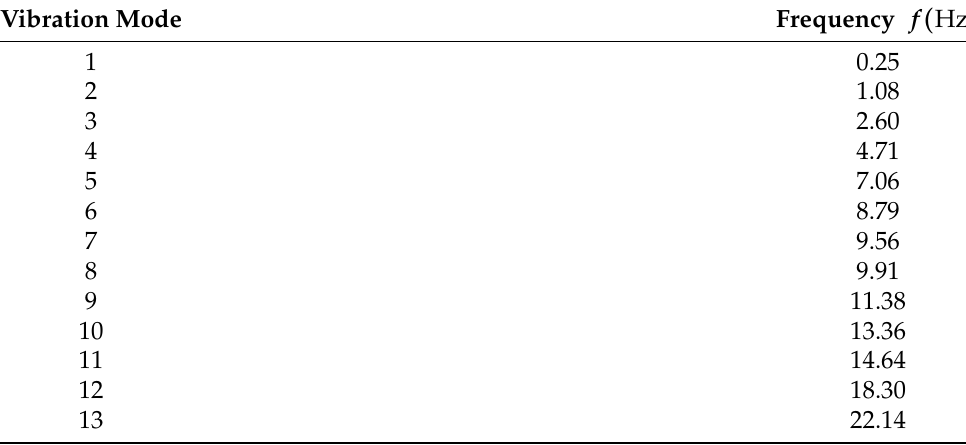
Table 5. Fundamental vibration frequencies of the Pirelli